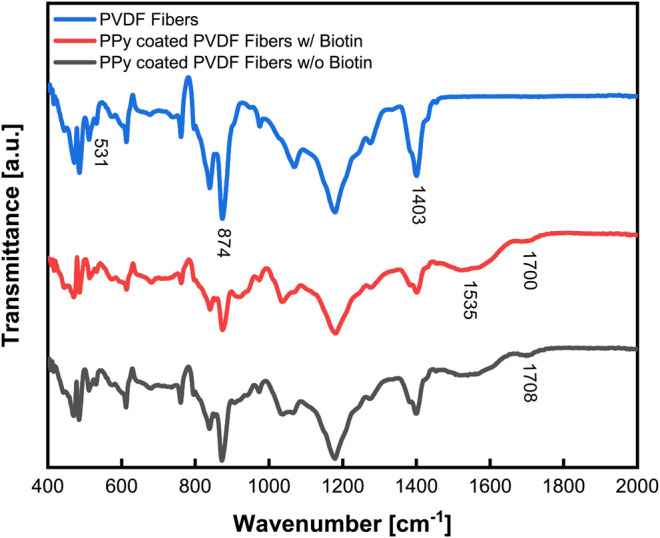
Fourier Transform Infrared Spectroscopy (FTIR) characterization of PPy coating on PVDF with biotin incorporated as a co-dopant. Spectra of PVDF electrospun fibers (top line, blue), had a high ß ratio of 75% indicative of piezoelectric properties, while PPy coating was demonstrated on the PVDF fibers (middle and bottom lines, red and gray) by characteristic peaks at 1,535 and 1700 cm−1. Evidence of biotin incorporation (red vs. gray) is seen by an overlap of peaks resulting in a shift at 1708 cm−1.